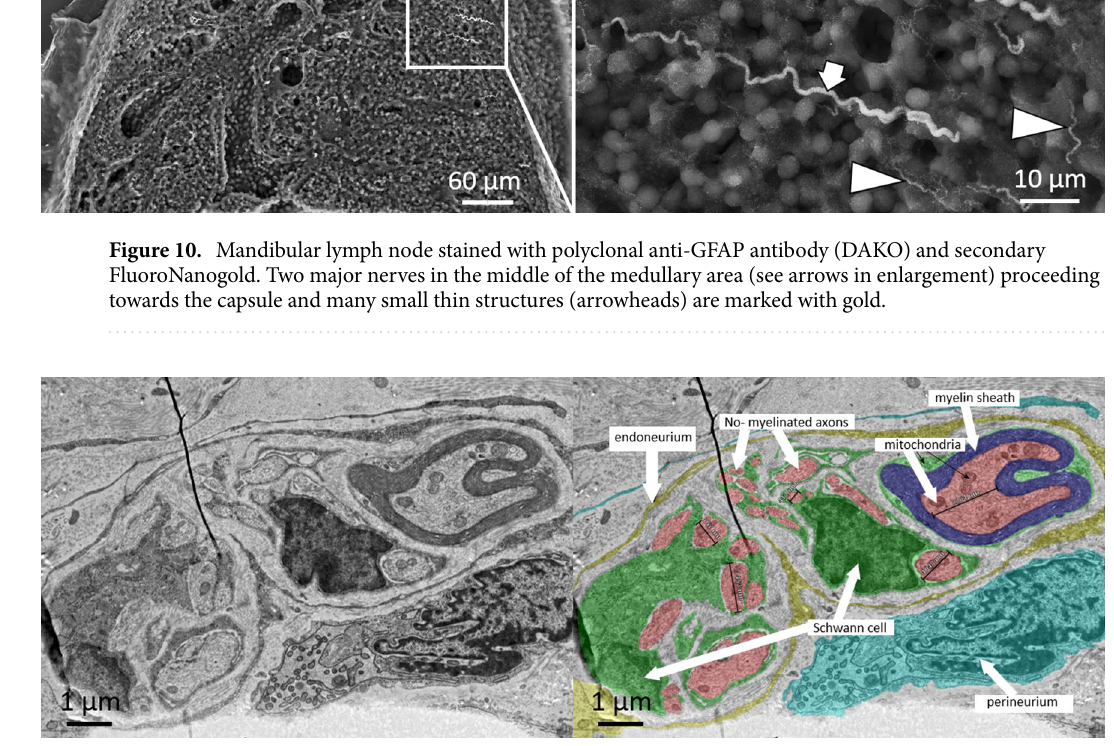
Figure 11. Ultrastructure image by TEM of a nerve within the medulla of an inguinal lymph node. Both, perineurium and endoneurium are well identifiable. At least two Schwann cells in this bundle accompany the non-mylelinated axon. The smallest axons have a diameter less than 400 nm. Furthermore, a myelinated axon with a diameter of ca. 2000 nm exits in this bundle.